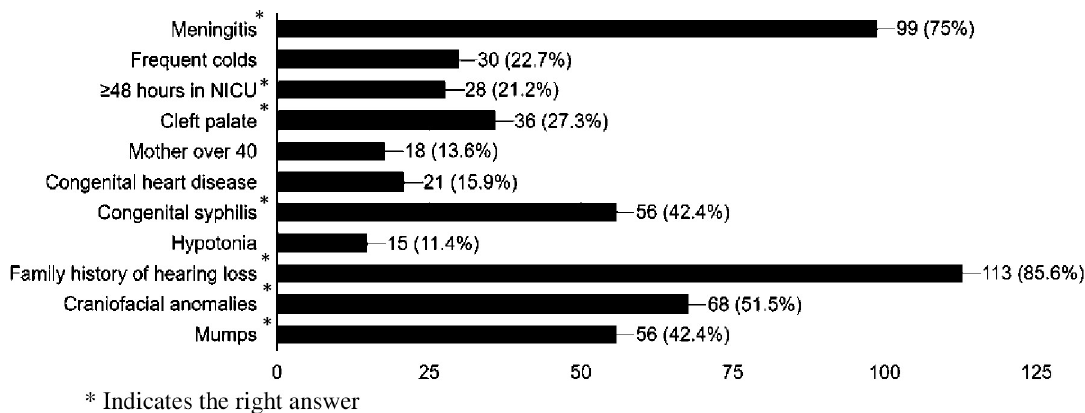
Fig 1. Risk factors associated with permanent hearing loss in the pediatric population.